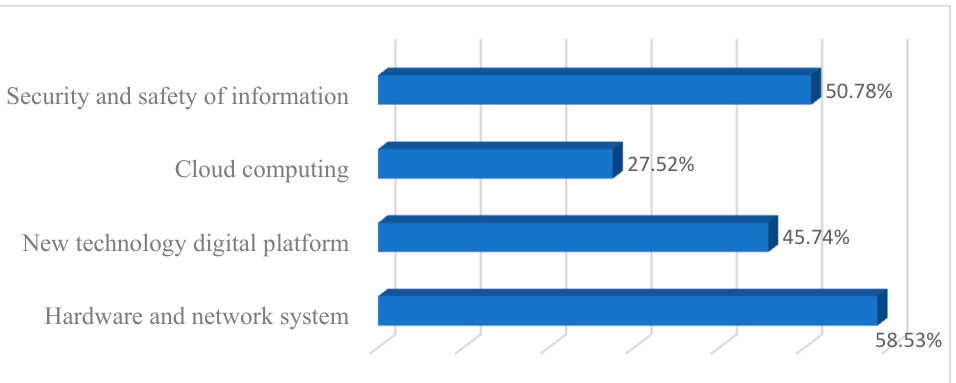
Figure 7. Infrastructure of Information Technology.